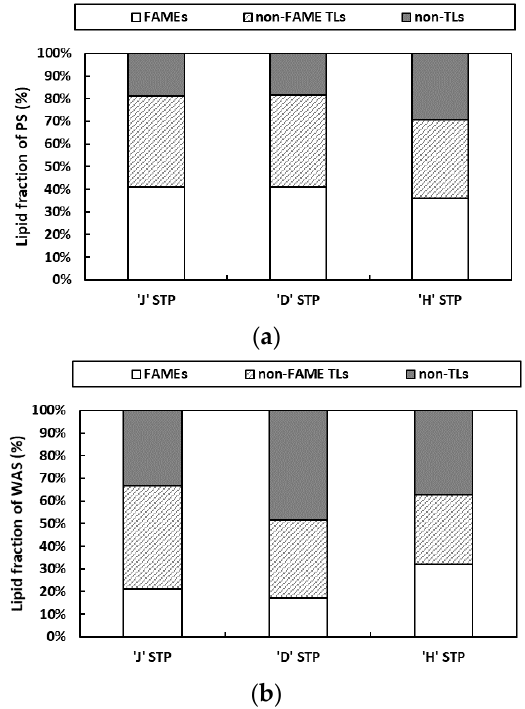
Figure 1. Mass fraction of lipids in ( a ) primary sludge (PS) and ( b ) waste activated sludge (WAS) extracted via in situ transesterification.